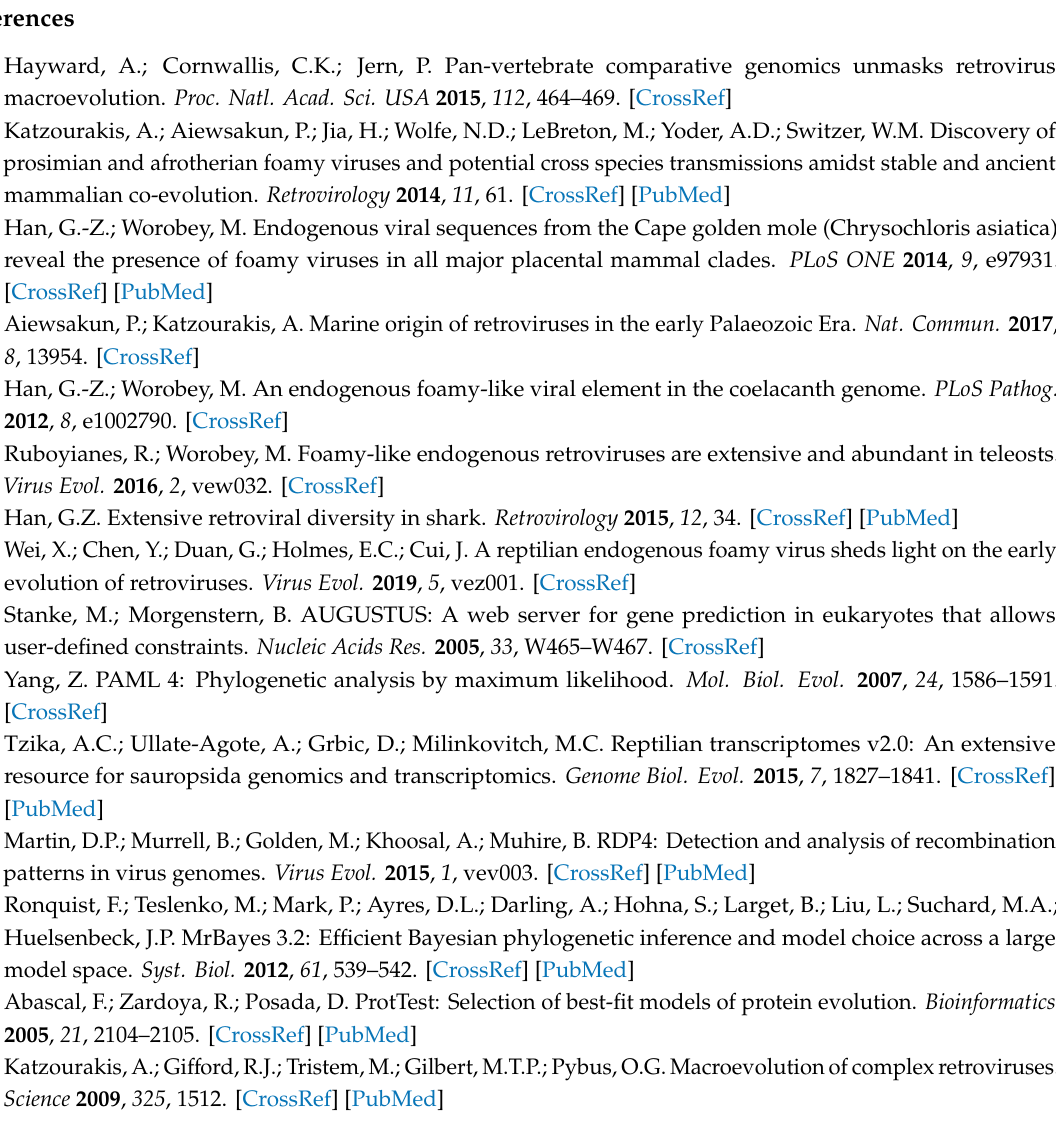
Figure S1: ERV-Spuma-Spu consensus sequence, Figure S2: Recombination detection in pol-env alignment, first round, Figure S3: Recombination detection in pol-env alignment, second round, Table S1: tBLASTn using CoeEFV Pol as probe against the tuatara genome, Table S2: Merged Pol hits and reciprocal BLASTx results, Table S3: tBLASTn using CoeEFV Env as probe against the extended Pol hits, Table S4: foamy virus-like endogenous viral elements in other reptiles, Table S5: host evolutionary timescales, Table S6: foamy virus-host association, Data S1: alignment of ERV-Spuma-Spu sequences – virus body portion, Data S2: alignment of ERV-Spuma-Spu sequences – long terminal repeat portion, Data S3: ERV-Spuma-Spu consensus sequence, Data S4: pol - env alignment, Data S5: Env alignment, Data S6 Pol